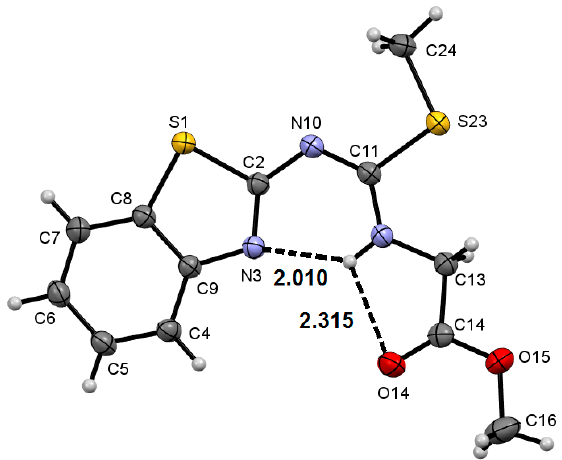
Figure 3. X-ray diffraction structure of compound 8a . Bond lengths (Å): S(1)–C(2) 1.7624(1), S(1)–C(8) Figure 3. X-ray di ff raction structure of compound 8a . Bond lengths (Å): S(1)–C(2) 1.7624(1),